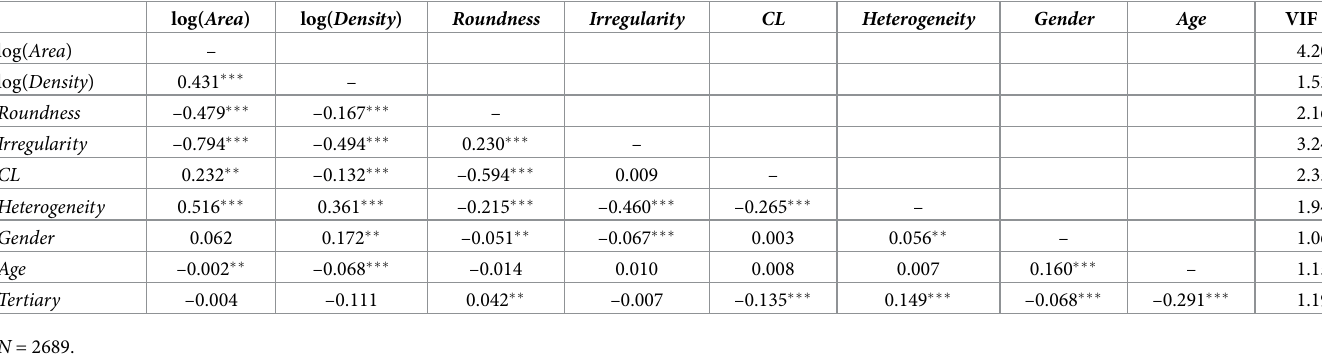
Table 2. Pearson correlation coefficient between the independent variables for the clusters with at least ten cells observed in 2005.